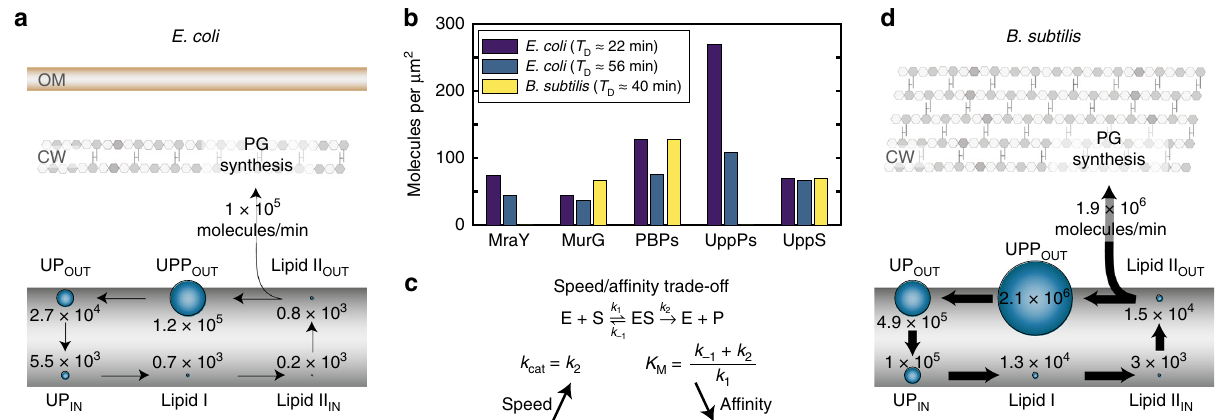
Fig. 2 Abundance of enzymes and lipid carrier intermediates in the lipid II cycle. a Pool level distribution of lipid II cycle intermediates and rate of PG synthesis predicted by the theoretical model for E. coli . b The surface concentration (number of enzymes per unit surface area) of the PG synthesis machinery is similar in Gram-positive and -negative organisms. c Increased catalytic rates of the lipid II cycle enzymes are expected to signi fi cantly speed- up the PG synthesis in Gram-positive organisms. As the catalytic rate k cat = k 2 also affects the Michaelis constant K M , an increase in the speed of an enzymatic reaction can decrease the af fi nity of the enzyme for its substrate. d Pool level distribution of lipid II cycle intermediates and rate of PG synthesis predicted by the theoretical model for B. subtilis . The signi fi cantly thicker PG layer in B. subtilis , which compensates the lack of an outer membrane, demands an increase in the rate of PG synthesis, implying higher levels of lipid II intermediates shuttling faster through the